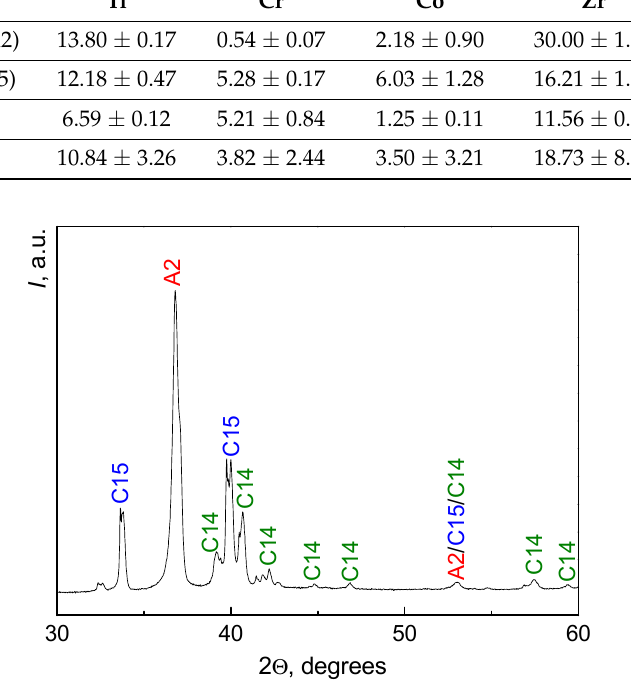
Figure 2. Diffraction pattern of the initial as-cast TiZrHfMoCrCo alloy.